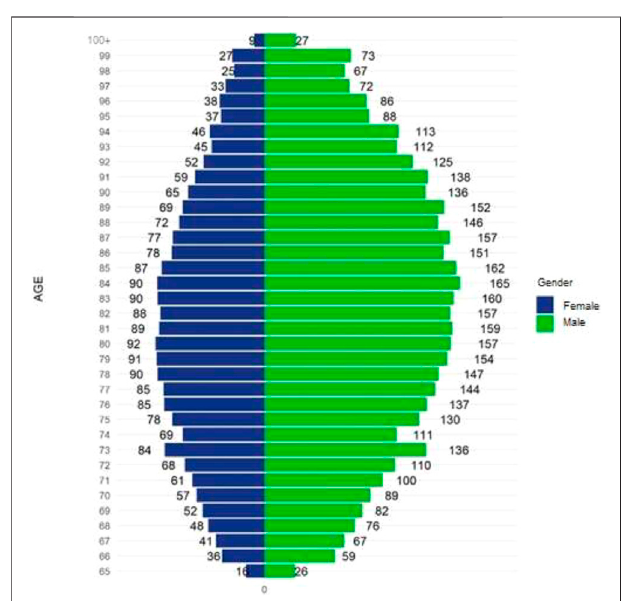
FIGURE 2 | Number of elderly patients on chronic polypharmacy in Poland in 2018 per 1,000 of inhabitants by age and gender.